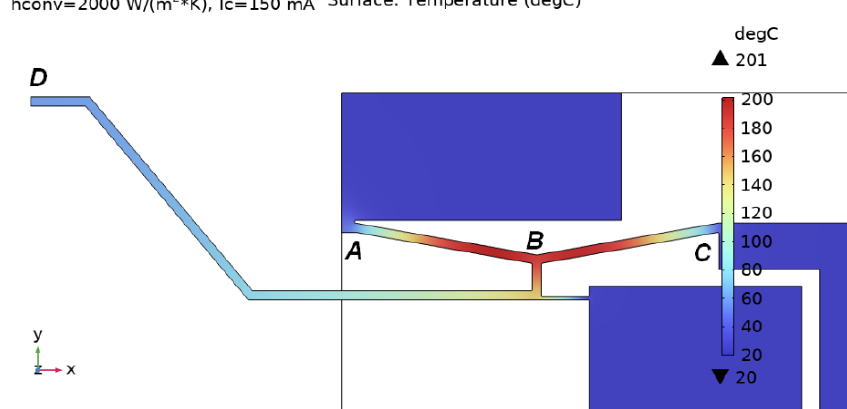
Figure 10. Temperature map of the micro-tweezer at 150 mA input current.